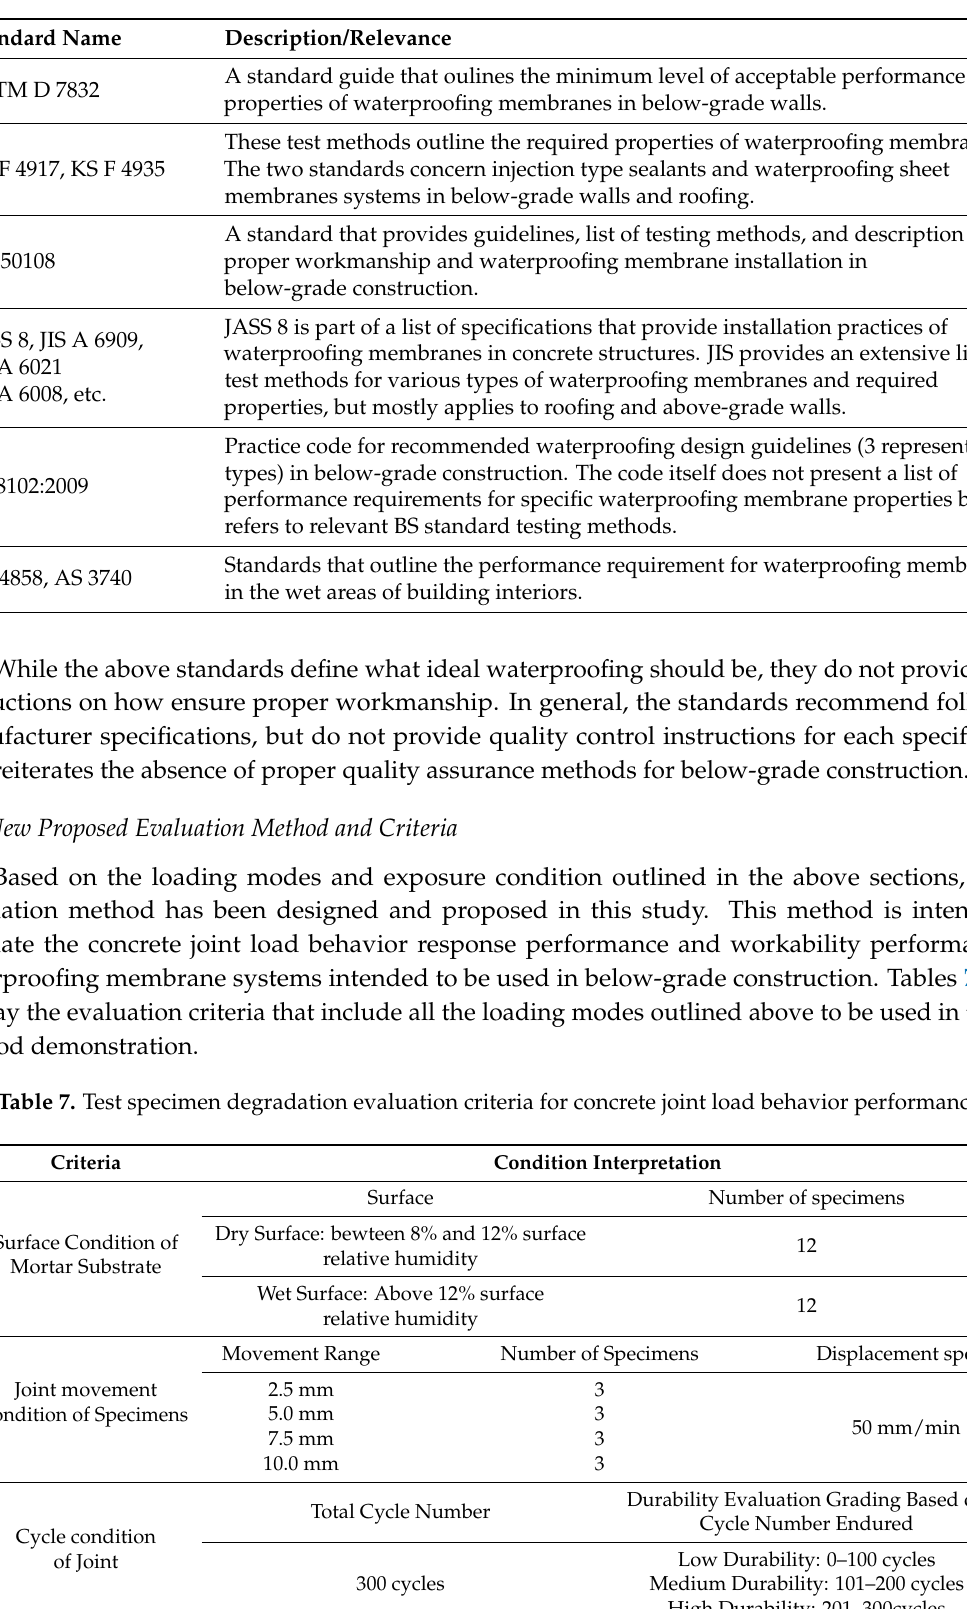
Table 6. International standards on required waterproofing membrane properties.